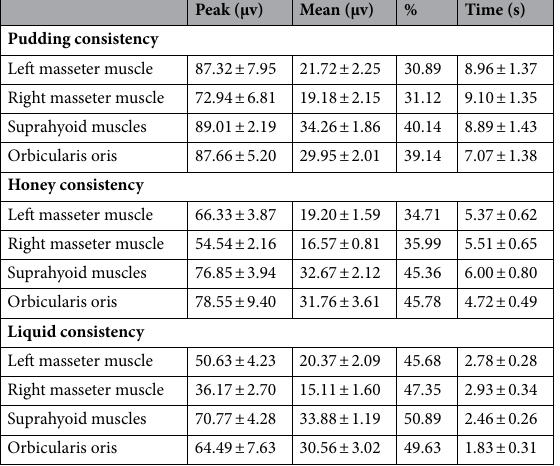
Table 2. sEMG results regarding mean peak and mean contractions (in root mean square—RMS), percentage of electrical activity, and muscle recruitment time during swallowing for pudding consistency. Descriptive analysis. % =